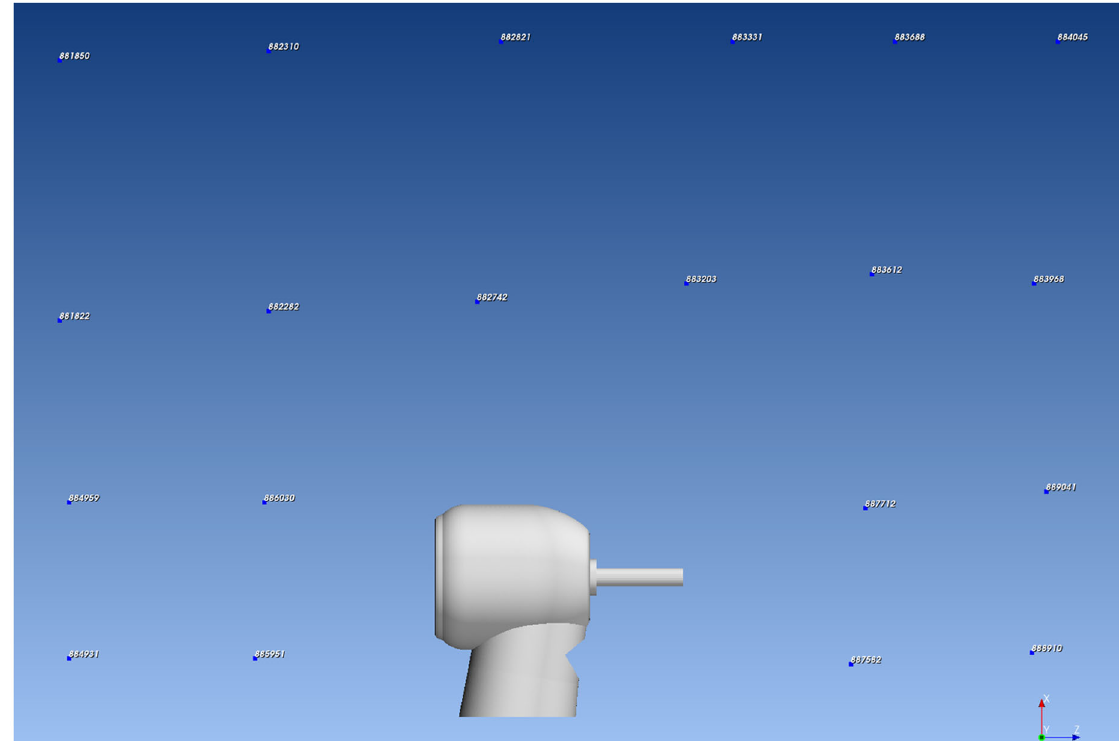
Fig. 4 Microphone designation. The virtual microphones were designated as individual